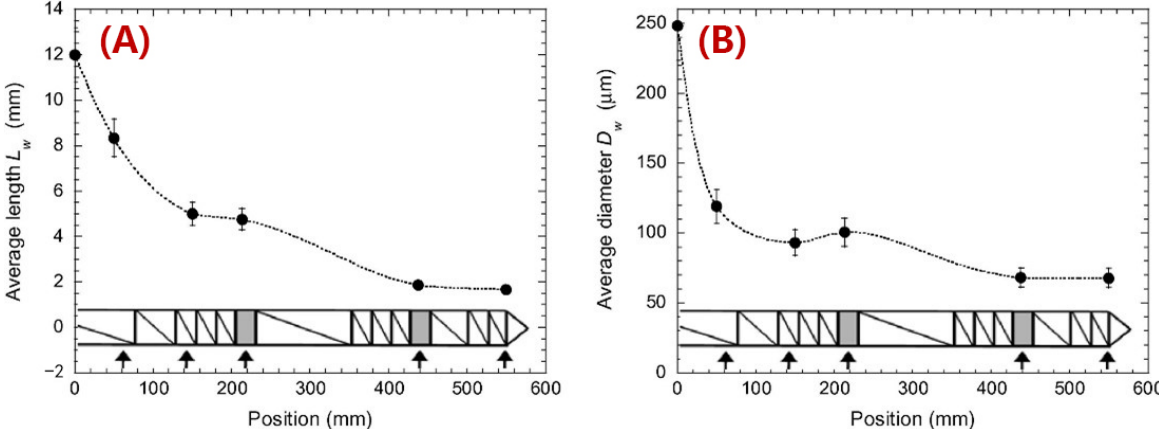
Figure 14. Changes in length ( A ) and diameter ( B ) of 12 mm flax fibers along the screws (2 kg/h, 100 rpm). Lines are just to guide the eyes [128].